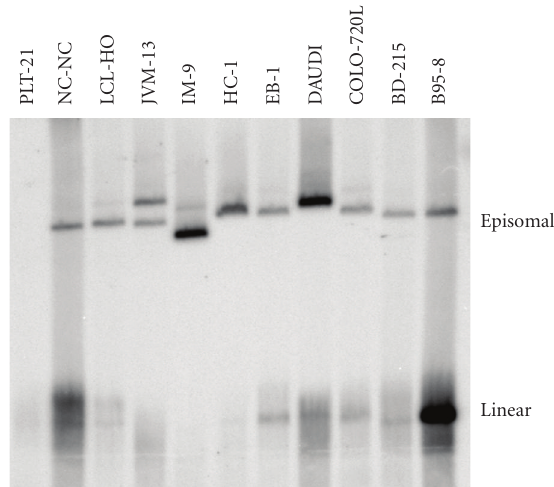
Figure 3: Detection of circular and linear EBV DNA in cell lines by in situ lysing gel analysis. 10 6 cells were resuspended in a loading bu ff er containing RNase A and loaded into a well of a 0.8% agarose-TBE lysing gel containing SDS and proteinase K. After electrophoresis the separated DNA was blotted onto nylon filters and the DNA was hybridized with 32 P labeled EBV cosmid cM- Sal I-A. The upper bands on the autoradiograph constitute the episomal DNA, whereas the lower bands constitute the linear EBV- DNA which is packed into the active viruses during virus formation. EBV genoms integrated into the chromosomes of the cells do not enter the gel. Controls include B95-8 as EBV-positive and PLT-21 as EBV-negative cell lines. Episomal EBV DNA can be detected in all EBV positive cell lines. The amount of linear EBV-DNA is highly diverse or not present (IM-9, JVM-13) and does not correlate with the amount of episomal DNA.